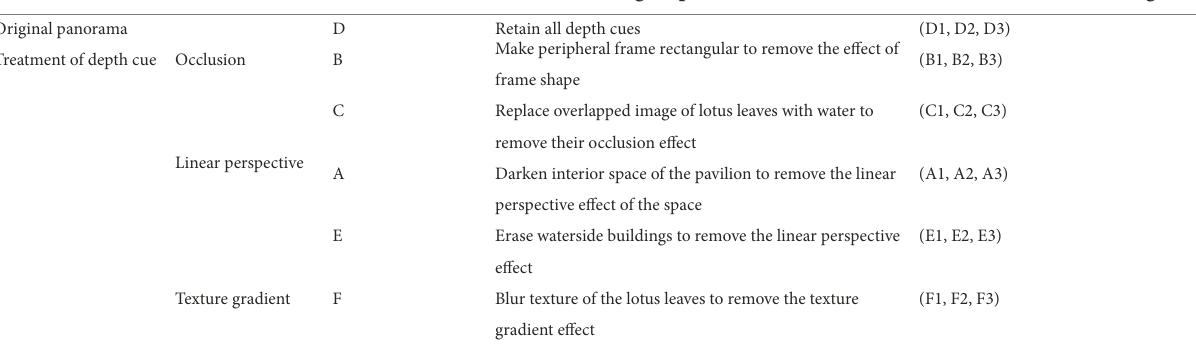
TABLE 1 The 18 kinds of stimuli (six image treatments * three